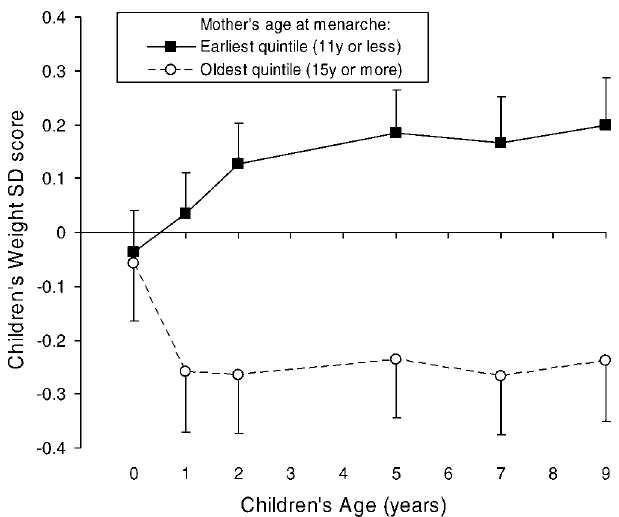
Figure 2. Contrasting Early Postnatal Growth Patterns in Offspring of Mothers with Earlier or Later Menarche Unadjusted weight SD scores are shown in children grouped by extreme quintiles of their mother’s age at menarche. Data are means 6 standard error from the Children in Focus subgroup ( n ¼ 914).